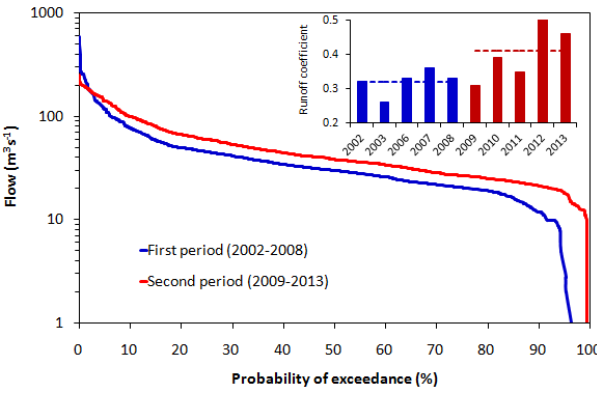
Figure 8. Flow duration curves for mean daily flow in the first period (2002–2003 and 2006–2008) and the second period (2009– 2013) (May–October) measured at the Wuding station in the Qin- huai River basin. The insert shows the runoff coefficient, the ratio of stream flow/precipitation for the period from May to October when the flow control gate was open.